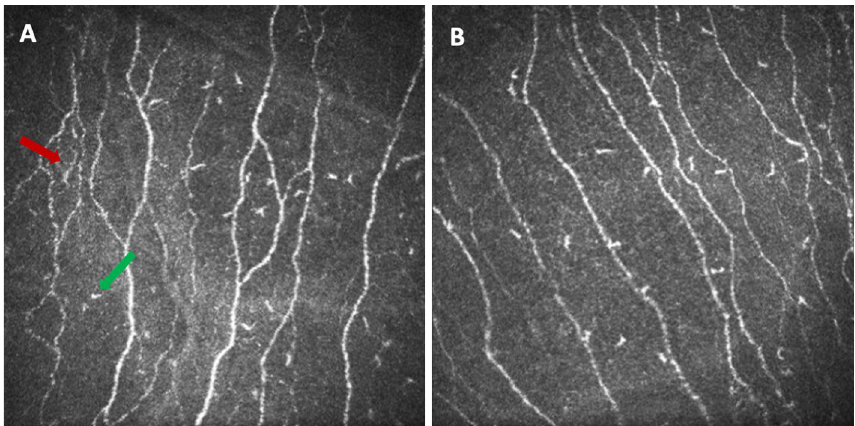
Figure 1. ( a ) A CCM image of the sub-basal nerve plexus in a healthy control and ( b ) a child with celiac disease (CeD) with mature (red arrow) and immature LCs (green arrow).